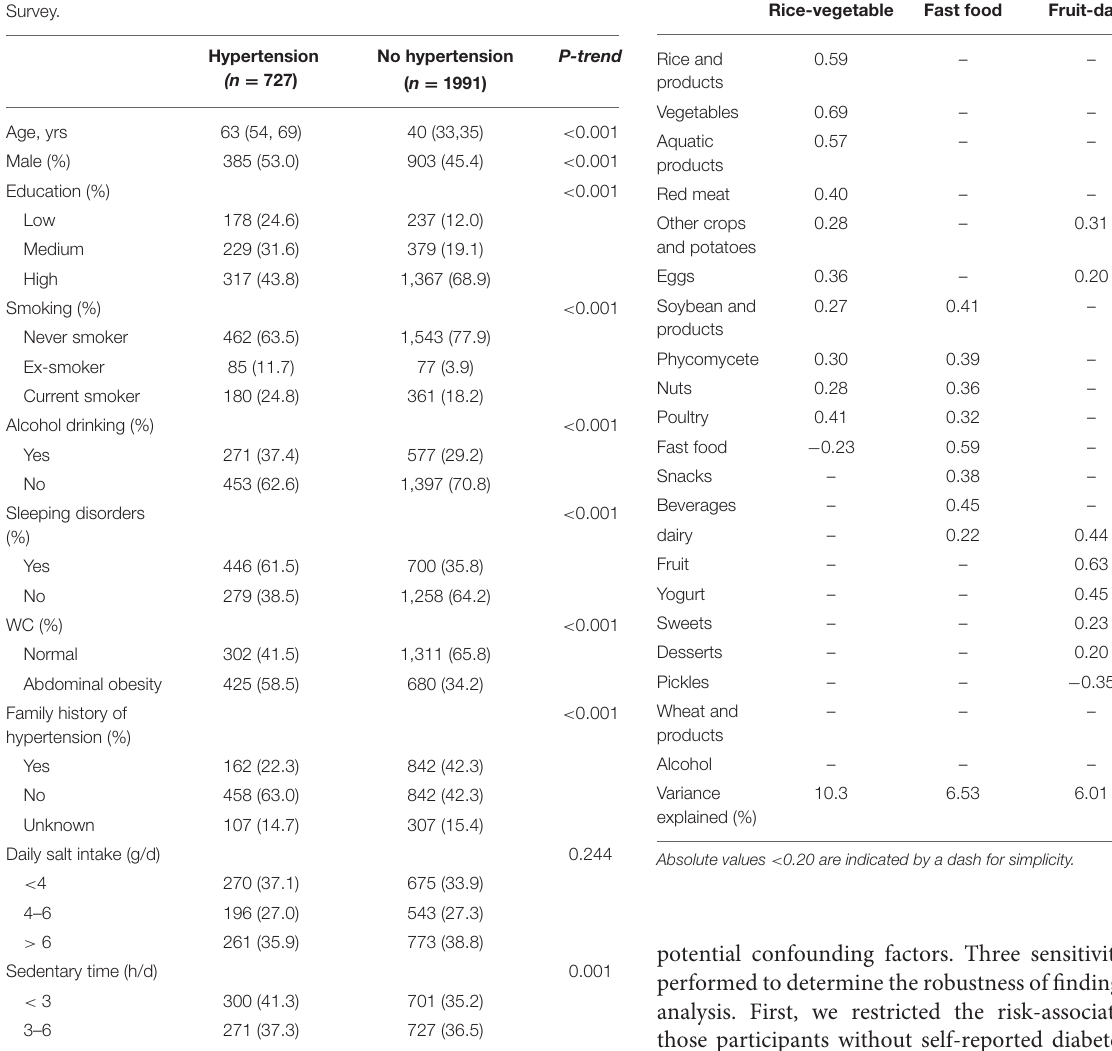
TABLE 1 | Sociodemographic and lifestyle characteristics between participants with and without hypertension: The Suzhou Food Consumption and Health